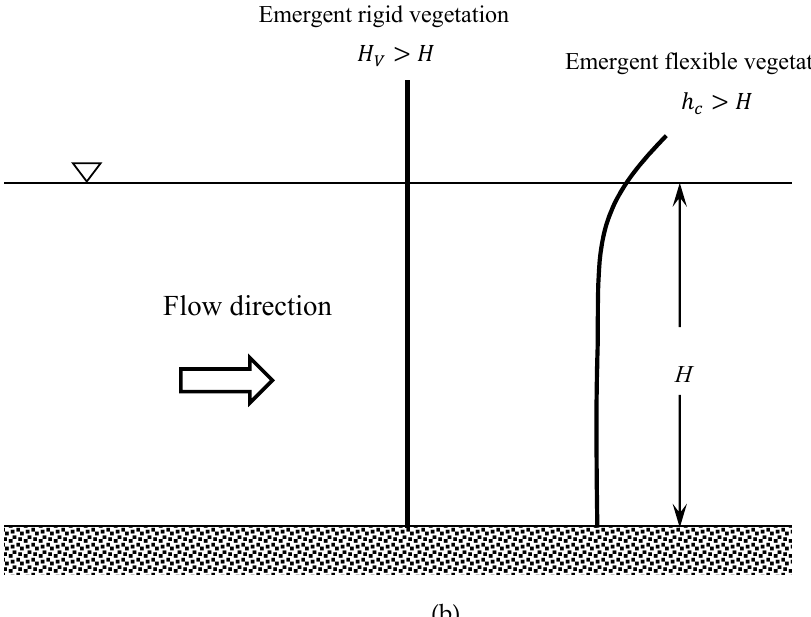
Figure 2. (a) Classification of aquatic plants; ( b ) emergent vegetation types based on plant stiffness.